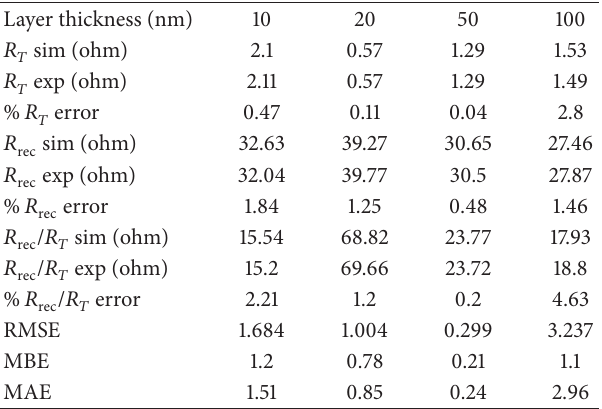
Table 4: Resistance error percentage.